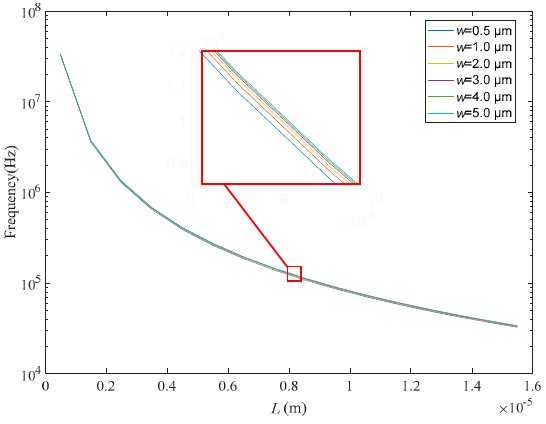
Figure 2. Natural frequency verse the length and width of graphene beam.